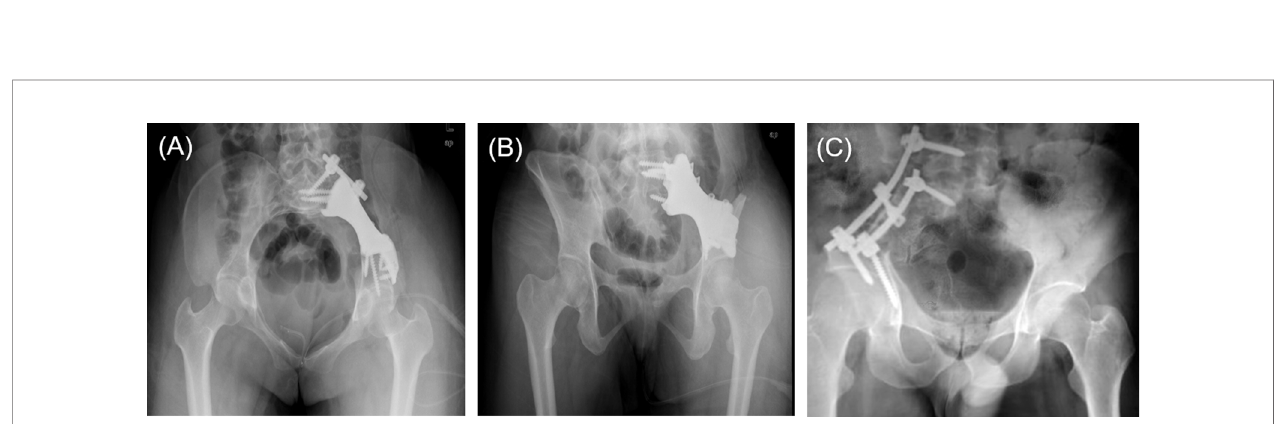
FIGURE 3 | (A) The 3D-printed endoprosthesis with screws fi xed on. Extra pedicle screw design was added in case of unsatisfactory implantation of the endoprosthesis. The contact interface of endoprosthesis-iliosacral region was modi fi ed as porous hydroxyapatite design to facilitate bone ingrowth and osseointegration. (B) The virtual surgery on printed model with 3D-printed endoprosthesis implantation. (C) The resection of the ilium side and tumor exposure with complete capsule. The PSI was fi xed on the ilium with Kirschner wire. (D) The resection of the sacrum side. (E) The resection was done in a straightforward manner with swing saw through the groove designed in the PSI. (F) The resected tumor. (G) Section view of the resected tumor. (H) The endoprosthesis has been implanted precisely.